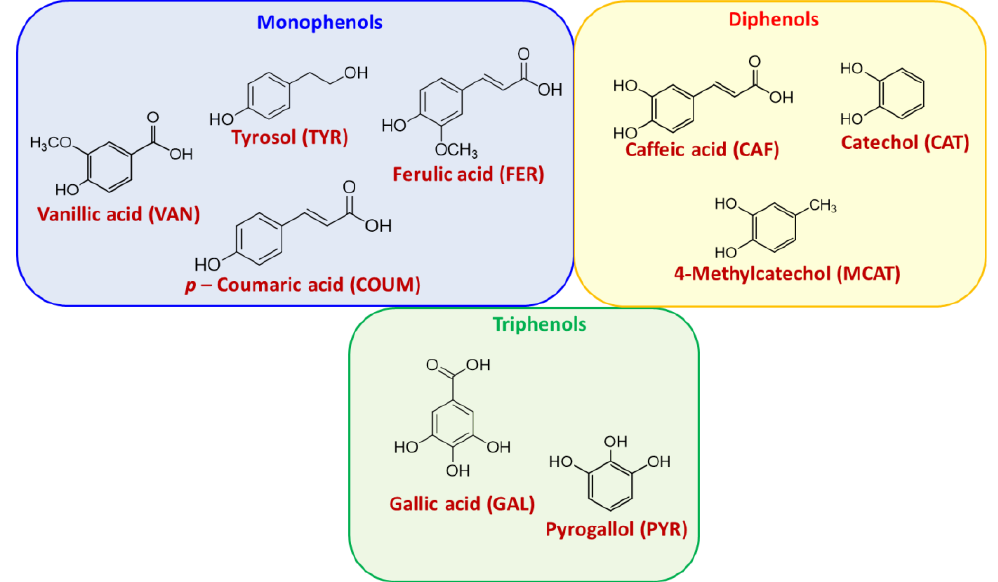
Figure 1. Natural phenols used for the preparation of polymers.